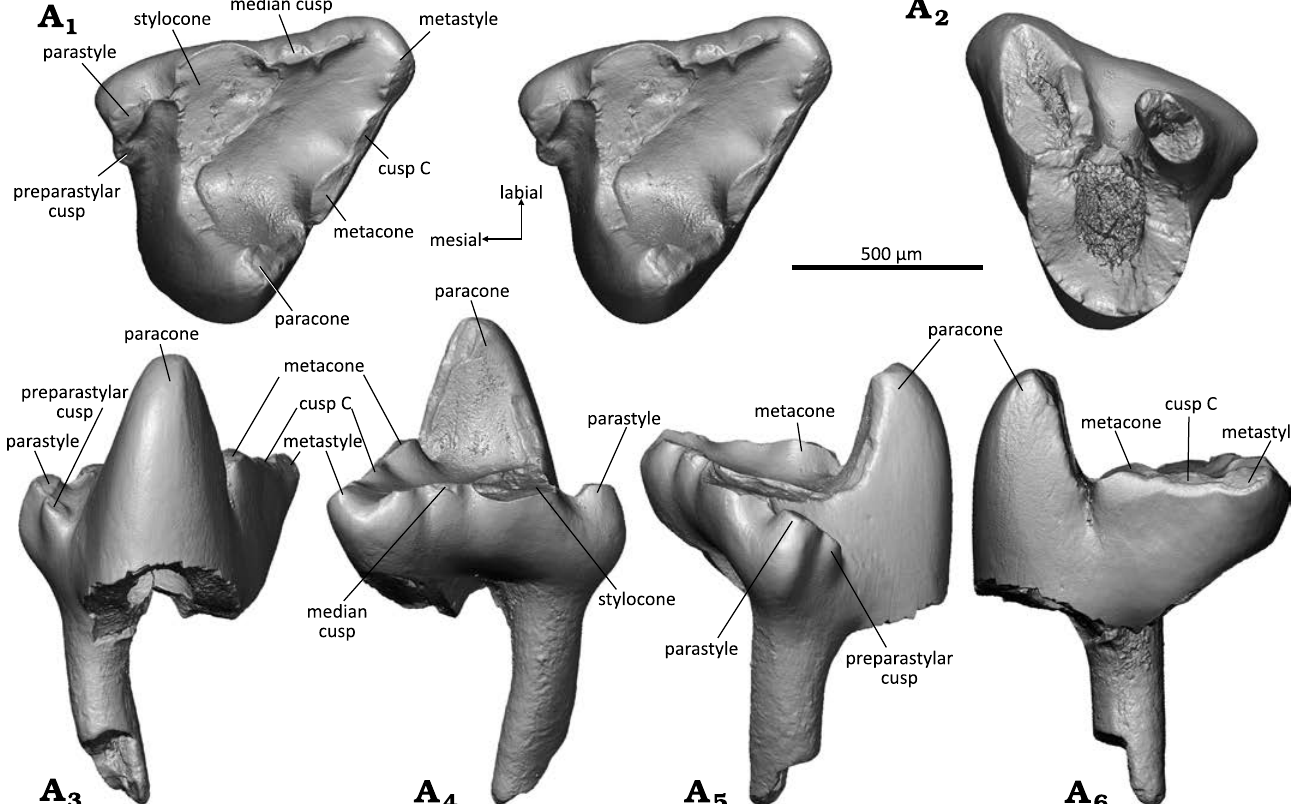
Fig. 6. Dryolestid mammal Minutolestes submersus gen. et sp. nov., WMNM P82306 (holotype) from Busche Quarry near Balve, North Rhine-Westphalia, Germany, Barremian–Aptian (Lower Cretaceous). Left upper molar in occlusal (stereopair, A 1 ), dorsal (A 2 ), lingual (A 3 ), labial (A 4 ), mesial (A 5 ), and distal (A 6 )